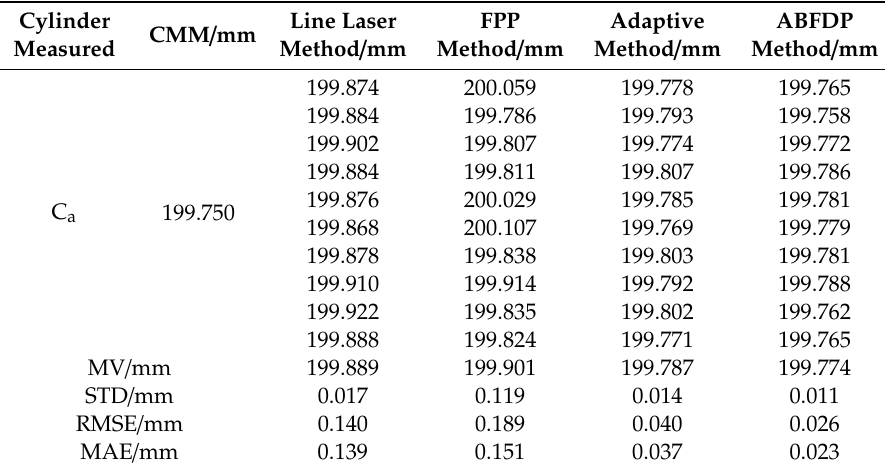
Table 2. Diameter measurement results of C a with di ff erent methods.